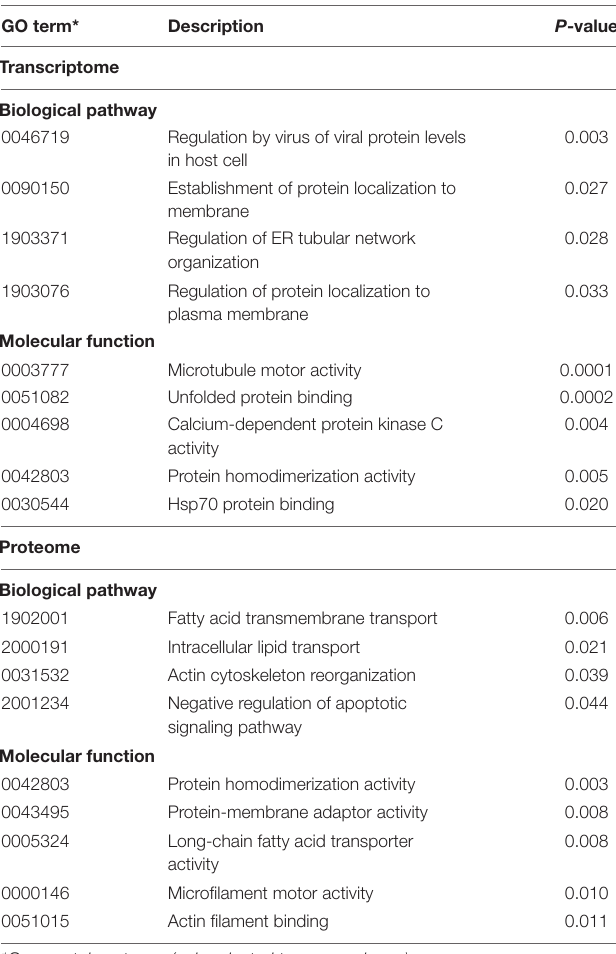
TABLE 1 | Gene ontology analysis of differentially expressed genes and proteins in RHDV2-infected rabbit liver